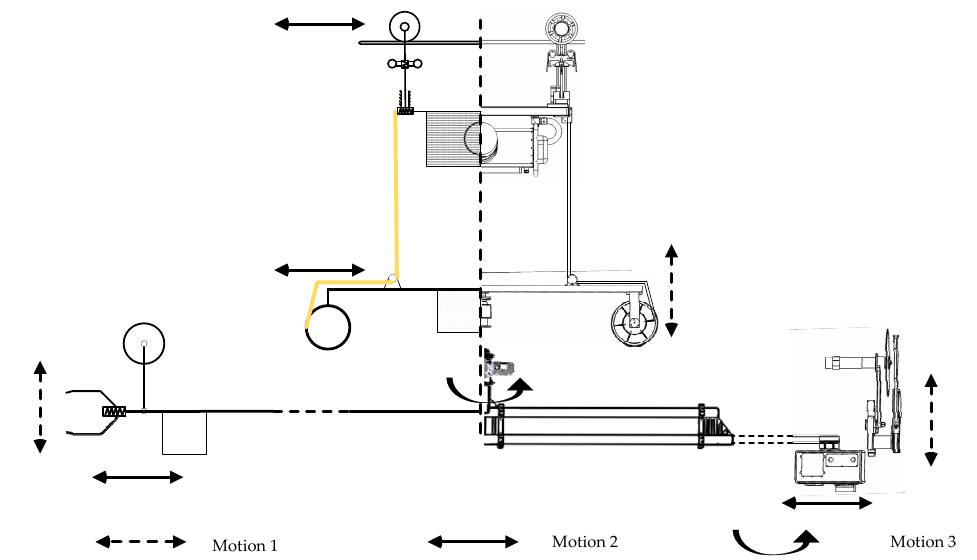
( b ) Figure 16. Implementations of fixed topologies in the experiment. ( a ) Star topology; ( b ) chain topology.